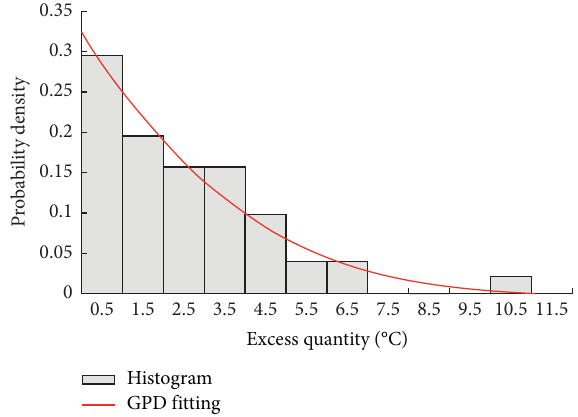
Figure 11: The PDF of the GPD for temperature excess quantity.